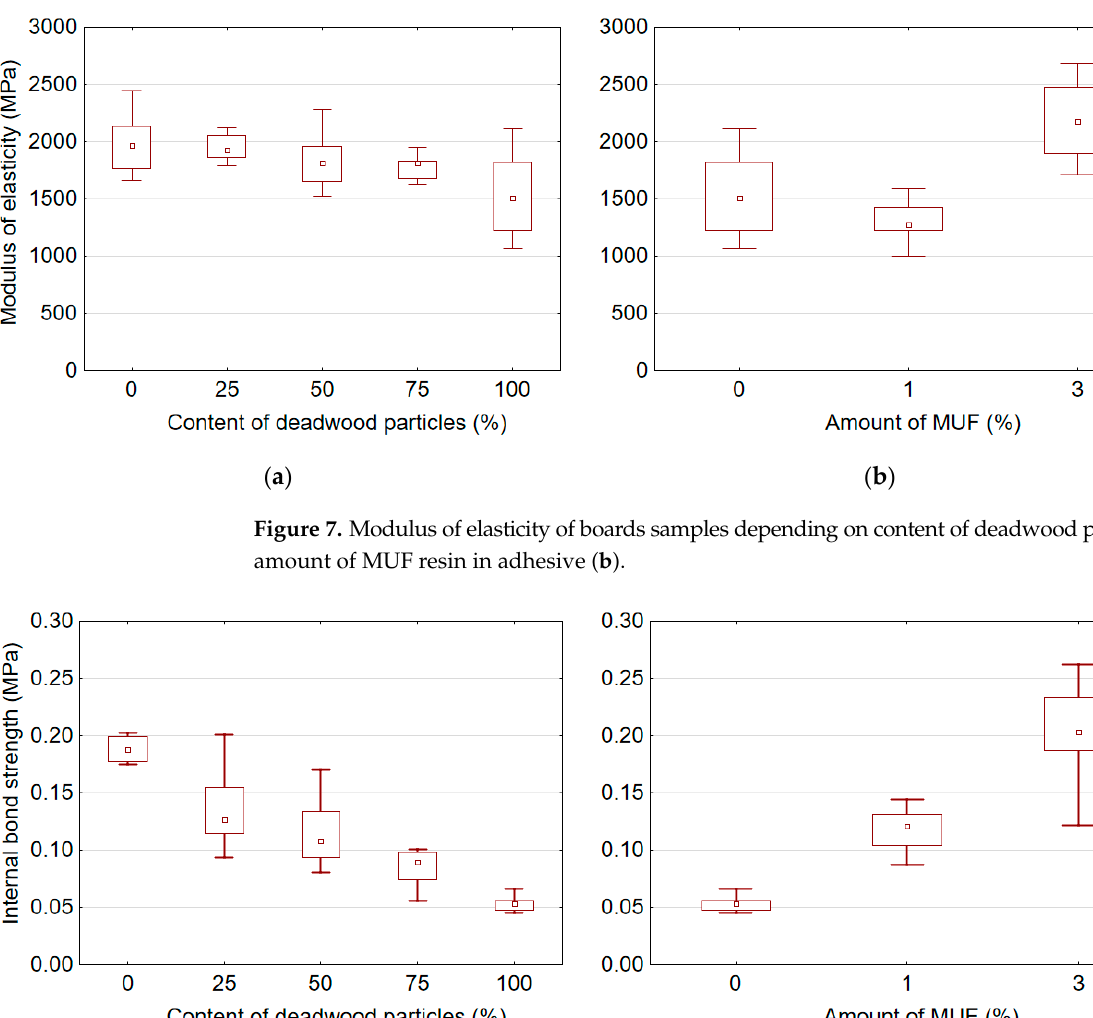
Figure 6. Bending strength of boards samples depending on content of deadwood particles ( a ) and amount of MUF resin in adhesive ( b ).